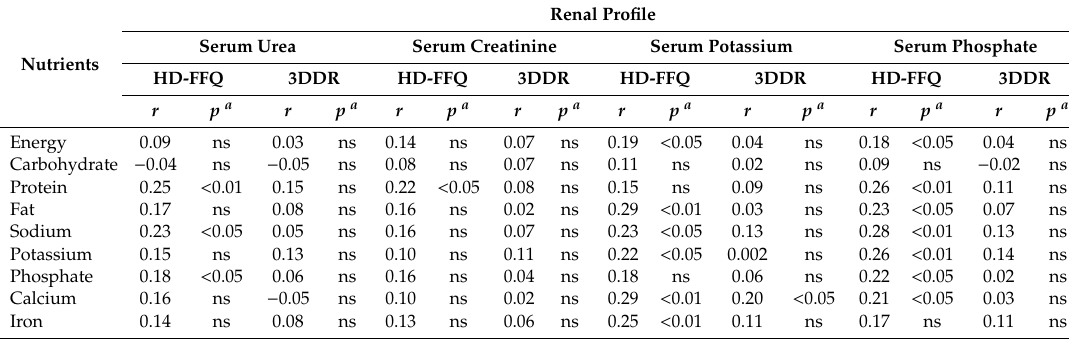
Table 4. Correlations of HD-FFQ and 3DDR with serum renal profile.